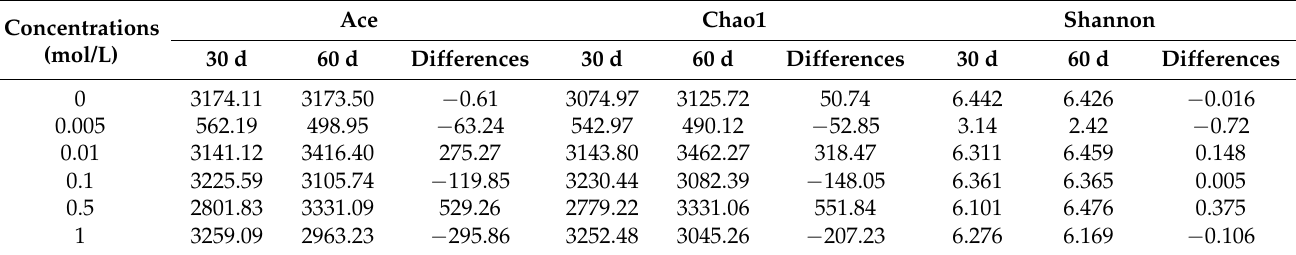
Table 4. Effect of pyrogallic acid on bacterial diversity.